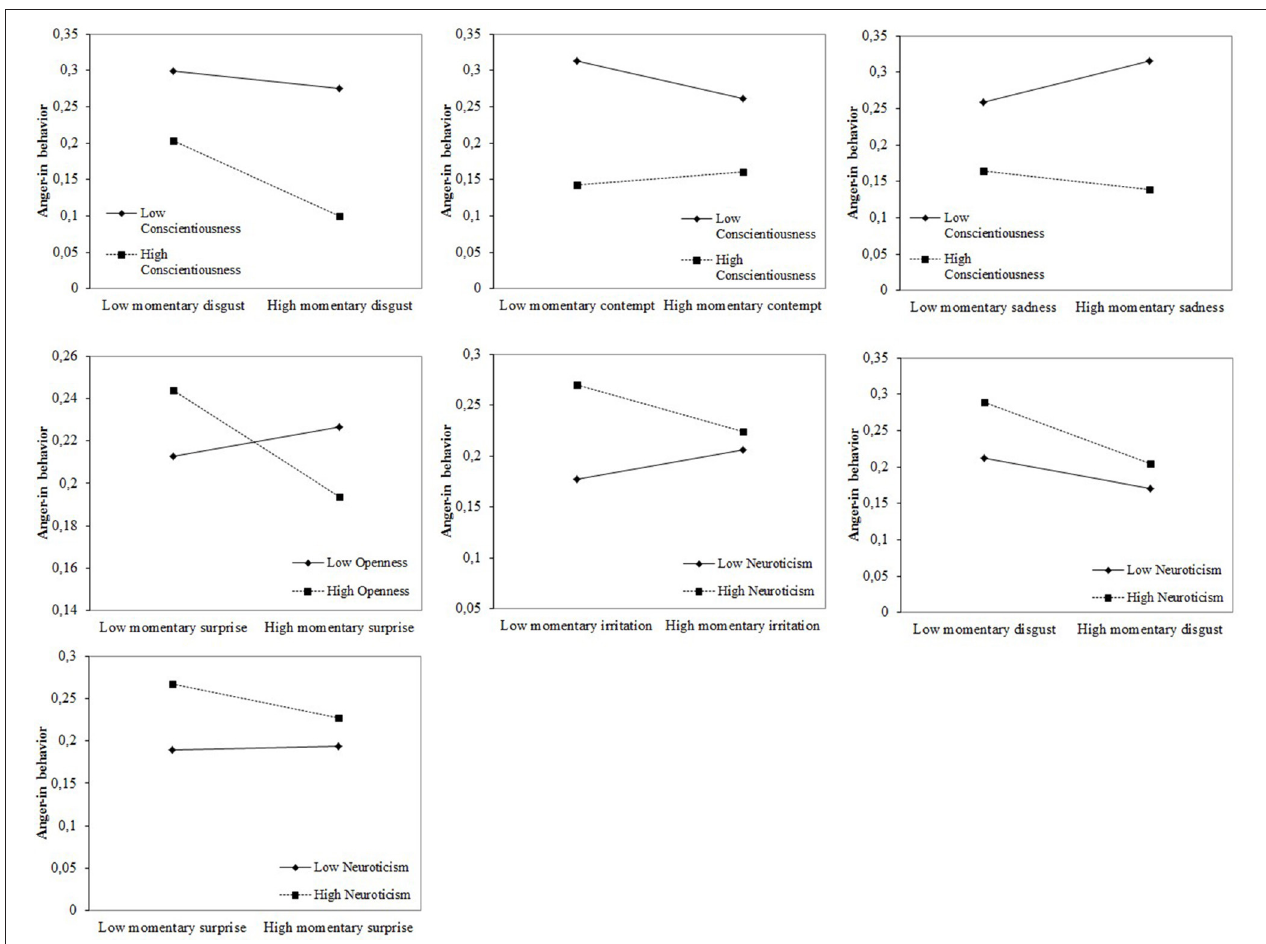
FIGURE 1 | Statistically significant interactions between momentary emotions and personality traits in predicting anger-in behavior.